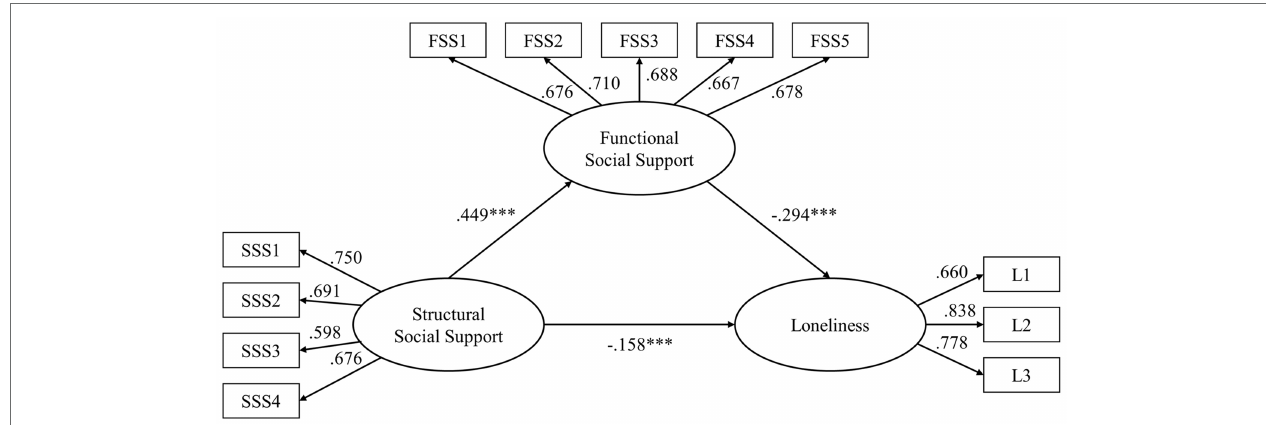
FIGURE 1 | Mediation model showing the relationship between structural social support and loneliness as mediated by functional social support. SSS, structural social support; FSS, functional social support; and *** p < 0.001.